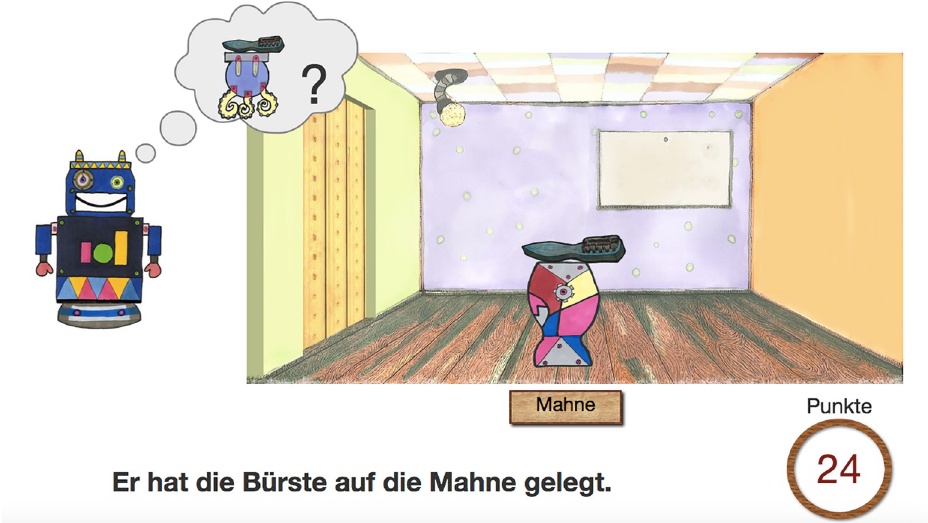
Fig 7. Example screen from the experiment during a trial with contrastive focus condition. (Image by Isabel Schwegel and Simon Roessig, CC-BY 4.0).